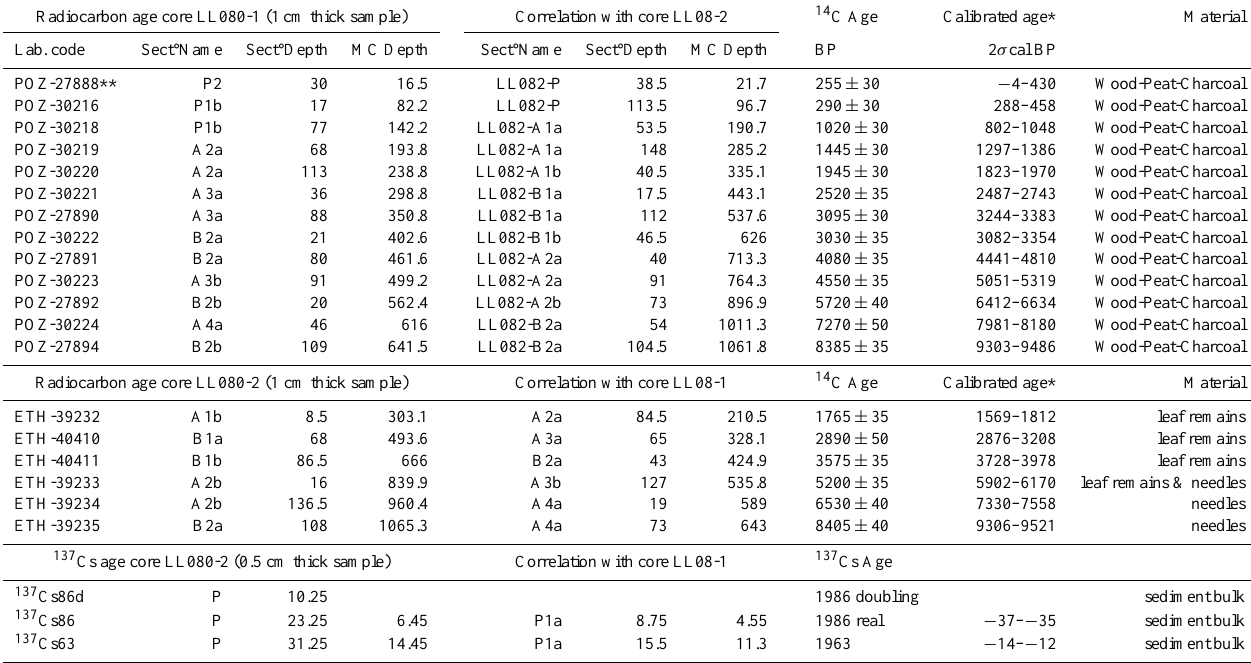
Table 1. Radiocarbon and 137 Cs ages of cores LL08-1 and LL08-2, with the correlations between them.